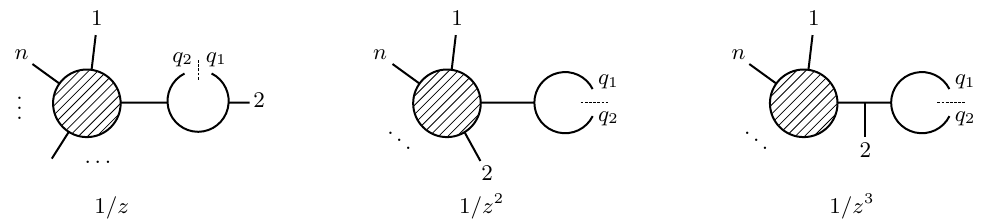
Figure 1 . Wave-function renormalisation and tadpole graphs divergent in the forward